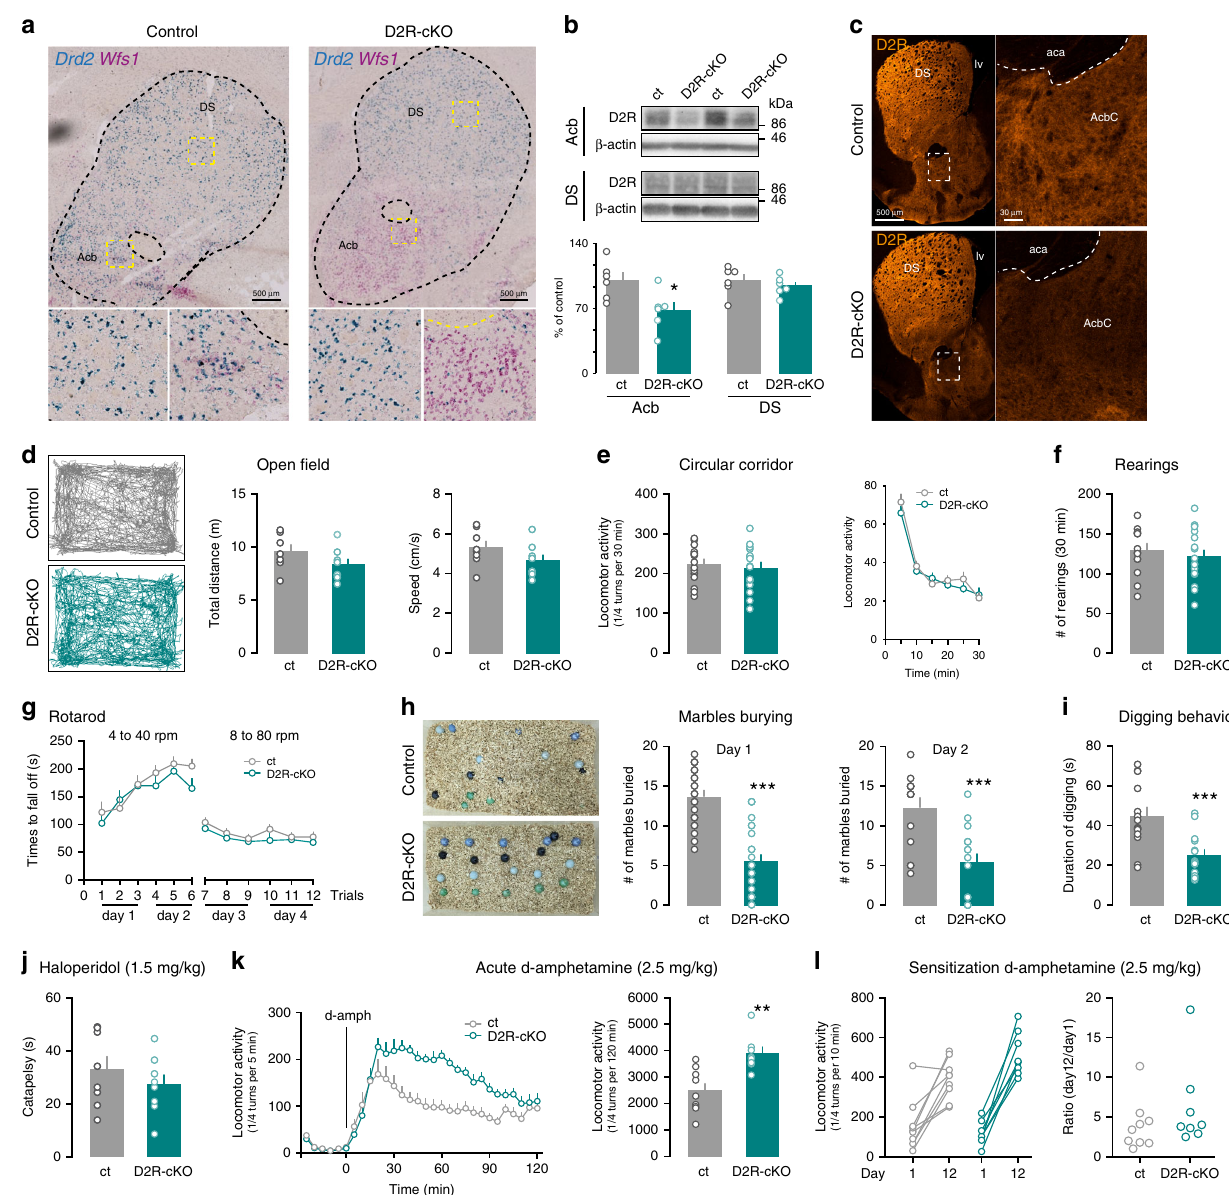
Fig. 6 Temporal deletion of Drd2 from WFS1 neurons alters digging behavior and amphetamine effects. a Double ISH of Drd2 (blue) and Wfs1 (magenta) in the striatum of control and D2R-cKO mice. b WB (top) and quanti fi cation (bottom) of D2R in control (ct) and D2R-cKO in Acb ( t 10 = 2.542, p = 0.0293, two-sided t test, n = 6 mice/group) and DS ( t 12 = 0.7706, p = 0.4588, two-sided t test, n = 6 mice/group). c Coronal section of D2R staining in D2R-cKO and ct. d Representative track traces (left), total distance traveled over 30 min (middle) ( t 13 = 1.51, p = 0.1549, two-sided t test, n = 7 ct and n = 8 D2-cKO), and average speed (right) ( t 14 = 1.563, p = 0.1405, two-sided t test, n = 8 mice/genotype). Horizontal ( e : t 28 = 0.8209, p = 0.4186, two- sided t test, n = 14 ct and n = 16 D2R-cKO) and vertical ( f : t 28 = 0.709, p = 0.4842, two-sided t test, n = 14 ct and n = 16 D2R-cKO) activity over 30 min in a circular corridor. g Accelerating rotarod performance of D2R-cKO and ct. Time to fall off is represented among the six trials at 4 – 40 rpm (time: F (5, 75) = 16.47, p < 0.0001; genotype: F (1, 15) = 0.7803, p = 0.3910; interaction: F (5, 75) = 1.314, p = 0.2672, two-way ANOVA repeated measures) and the